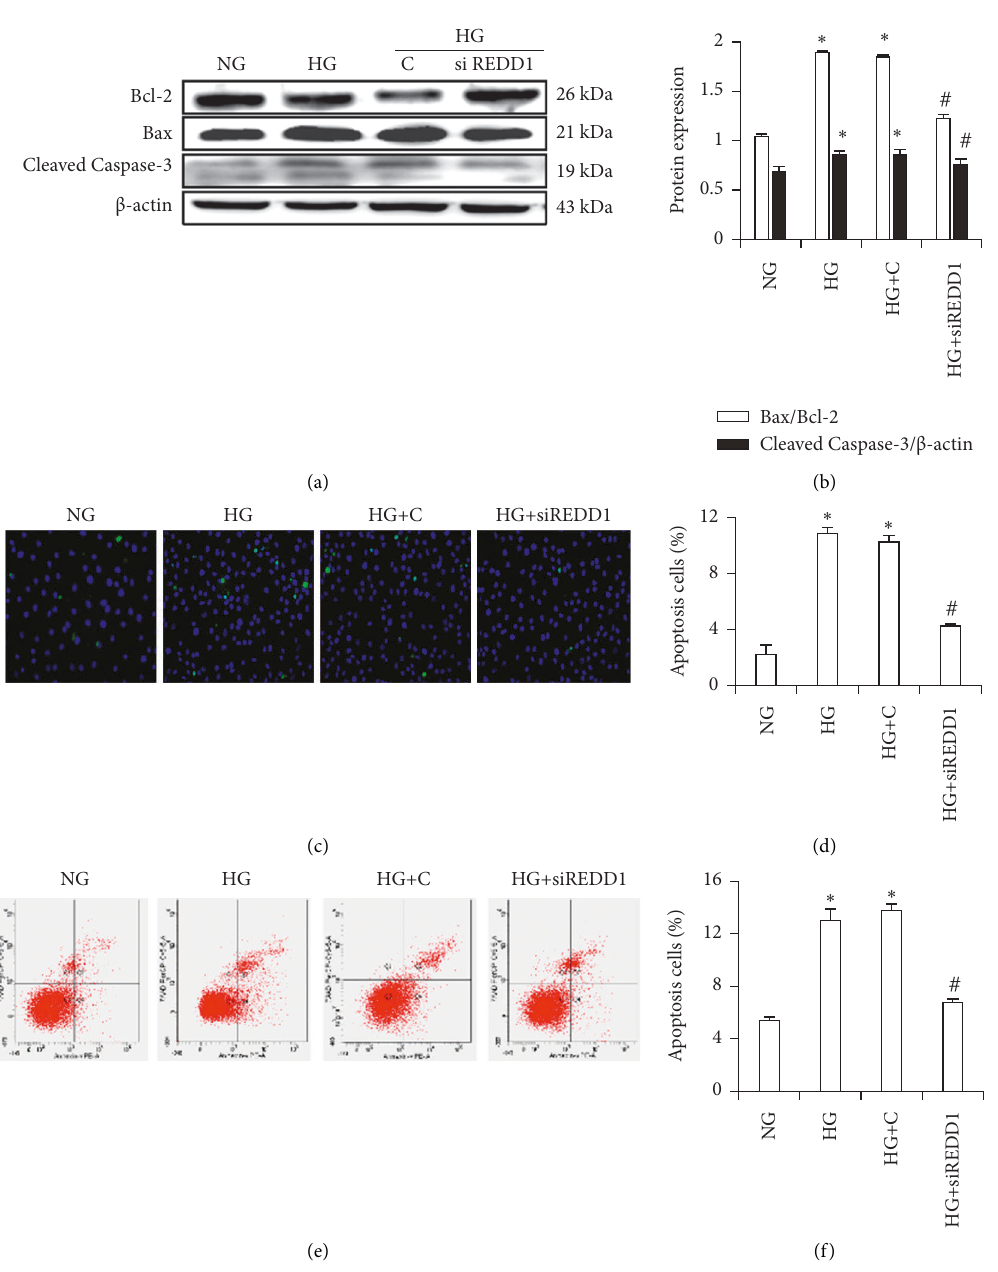
Figure 5: Knockdown of REDD1 inhibits HG-induced apoptosis in HK-2 cells. (a, b) Western blot of Bax, Bcl-2, and Cleaved Caspase-3 in HK-2 cells. (c, d) Apoptosis of HK-2 cells were analyzed by TUNEL assay. (e, f) Apoptosis rates of HK-2 cells were detected by flow cytometry analysis. Values are expressed as means SD ( n 6 per group). NG: 5.6 mM D-glucose; HG: 30mM D-glucose; HG +C: 30mM (cid:31) D-glucose plus scramble. HG+siREDD1: 30mM D-glucose plus REDD1 ±